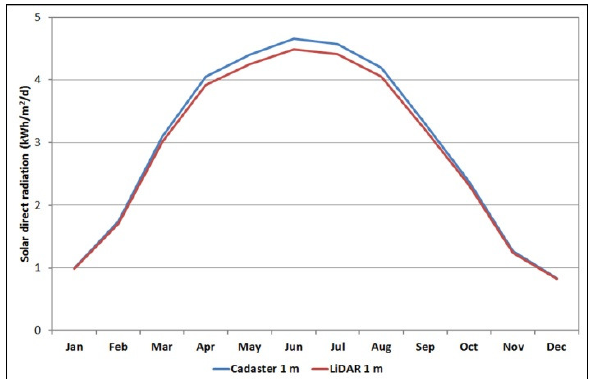
Figure 3 – Monthly solar radiation values from cadastral and LiDAR-based roof models, obtained averaging results from all 1300 buildings in the test area.